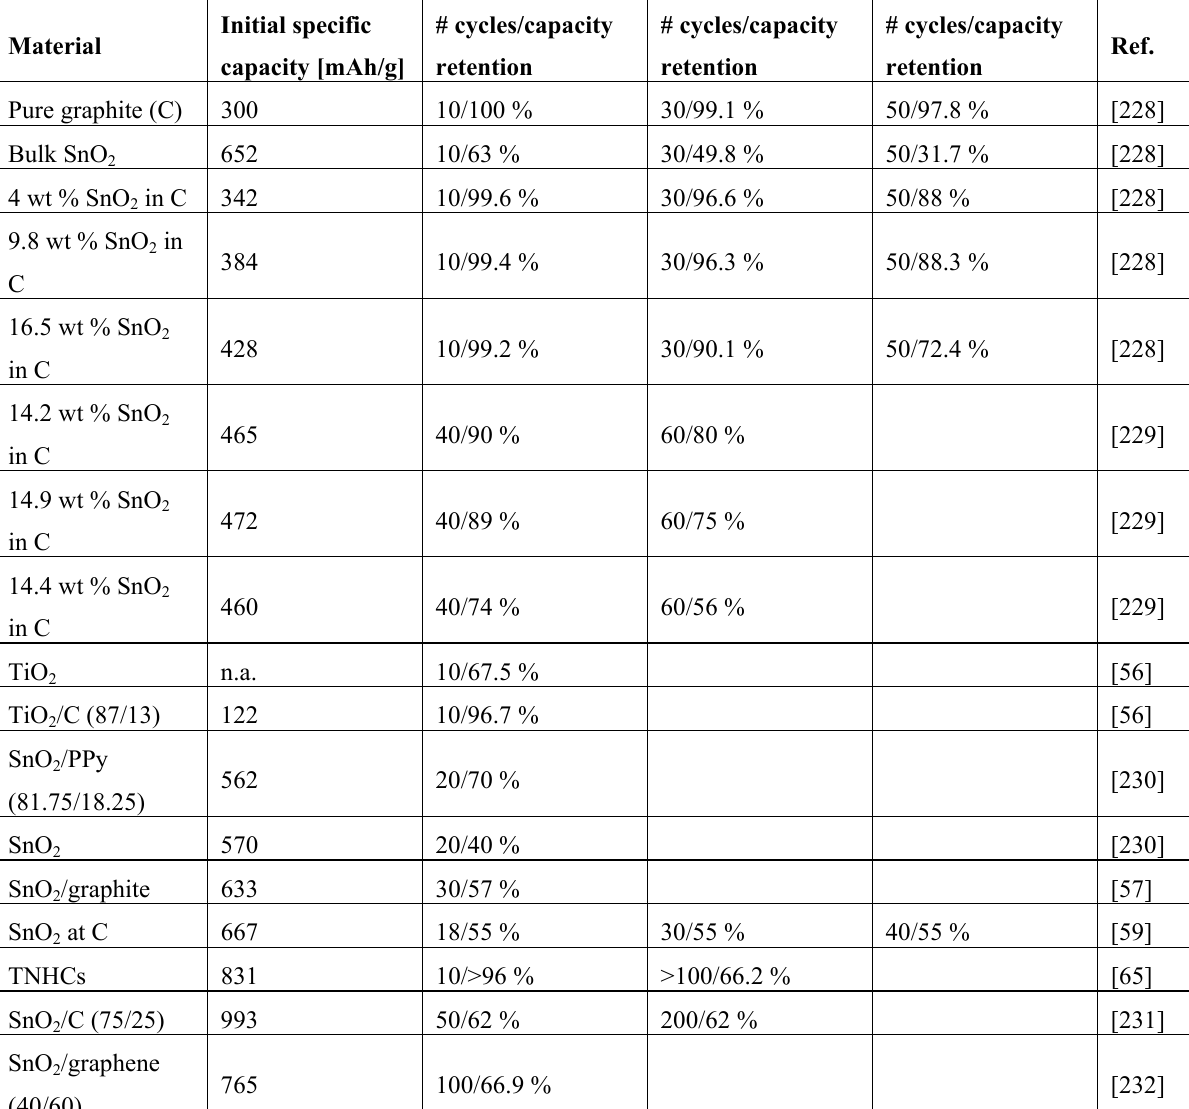
Table 6. Overview on performance of new nanocomposite anode materials for Li-ion